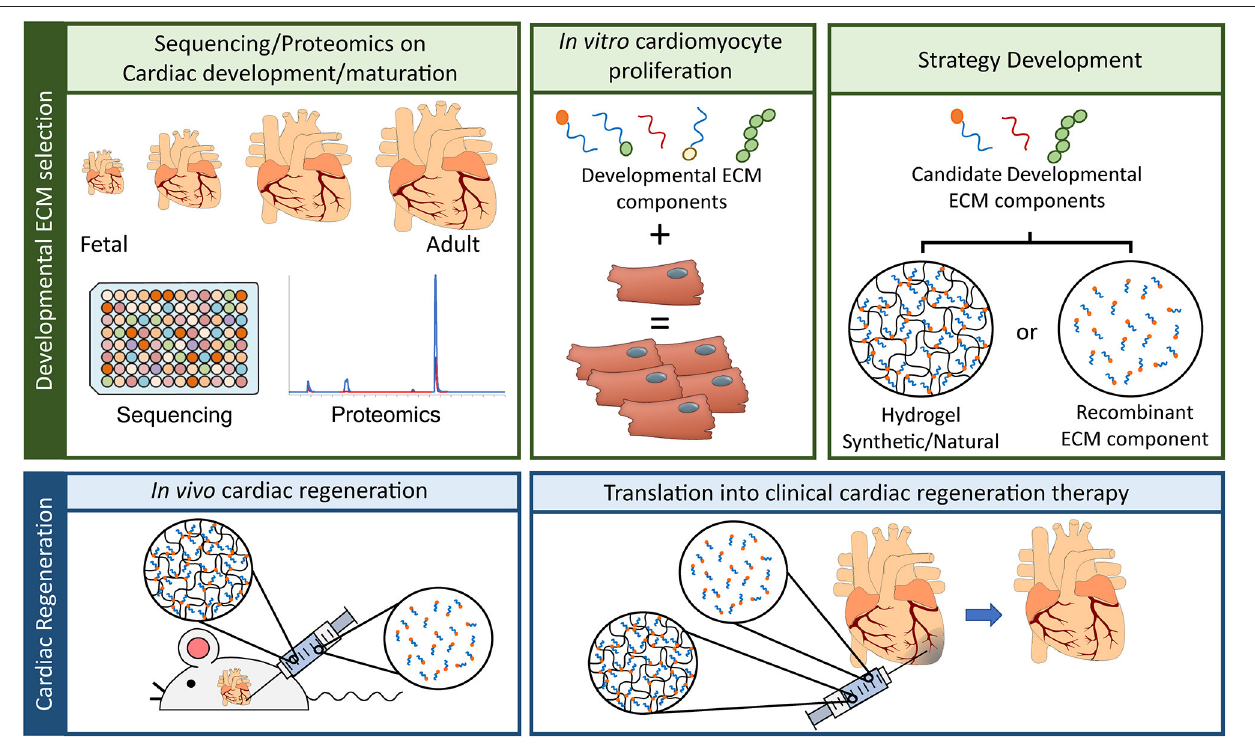
FIGURE 1 | Advancement in ECM based cardiac regenerative research. To advance the field of cardiac regeneration it is essential to take advantage of the innate regenerative capacity of the fetal mammalian heart. “Developmental ECM selection” will require: (1) the utilization of advancements in “-omics” techniques, such as RNA sequencing and proteomics, to identify key ECM components present in the fetal/developing heart, (2) developmental ECM components will need to be screened in vitro for their capacity to influence cardiac regeneration, a key component of which is the induction of cardiomyocyte proliferation, and (3) the delivery of candidate developmental ECM components will have to be determined, either by means of a naturally produced ECM hydrogel, a synthetically produced ECM hydrogel, or by direct administration of the recombinant ECM component (TOP panel, from left to right). Having selected the most suitable ECM component for cardiac regeneration and the delivery system, these will have to be tested for their in vivo capacity to induce cardiac regeneration. The first step will revolve around animal model experiments, either in a rodent model (as depicted) or in a large mammal model (i.e., pig) for heart failure. Here the developed hydrogel harboring the ECM of interest or the recombinant ECM solution will be administered to the animals to determine their efficacy in inducing cardiac regeneration and improving overall cardiac function. The final step, and most crucial, will be to translated this ECM based therapeutic strategy into the clinic.